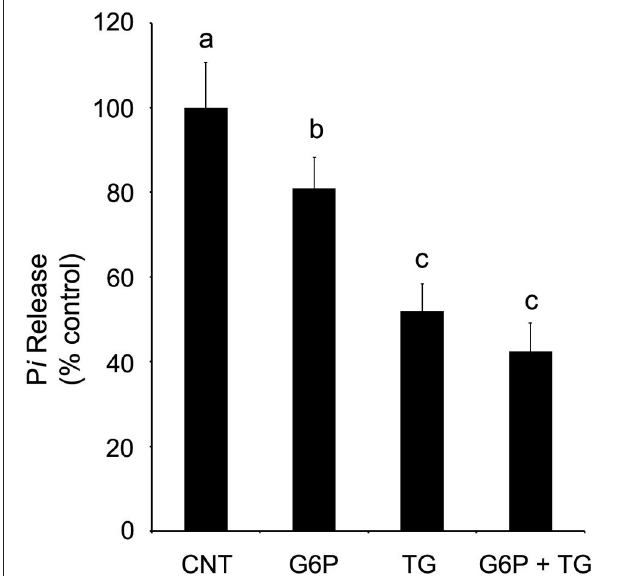
FIGURE 4 | Glucose-6-phosphate reduces SERCA activity, as quantified by the release of inorganic phosphate from rat brain ER microsomes, in comparison to control. Glucose-6-phosphate significantly reduced ( p < 0 . 05) the release of inorganic phosphate from brain ER microsome preparations after incubation for 6min. However, the decrease in SERCA activity was not as great as that observed with the addition of thapsigargin (1 µ M), a known potent, irreversible SERCA inhibitor. Treatment by both glucose-6-phosphate and thapsigargin did not further reduce accumulation below that of thapsigargin alone. Data are means ± SEM for n = 7. abc Means with differing superscripts are significantly different, p < 0 . 05, while means that share superscripts are not significantly